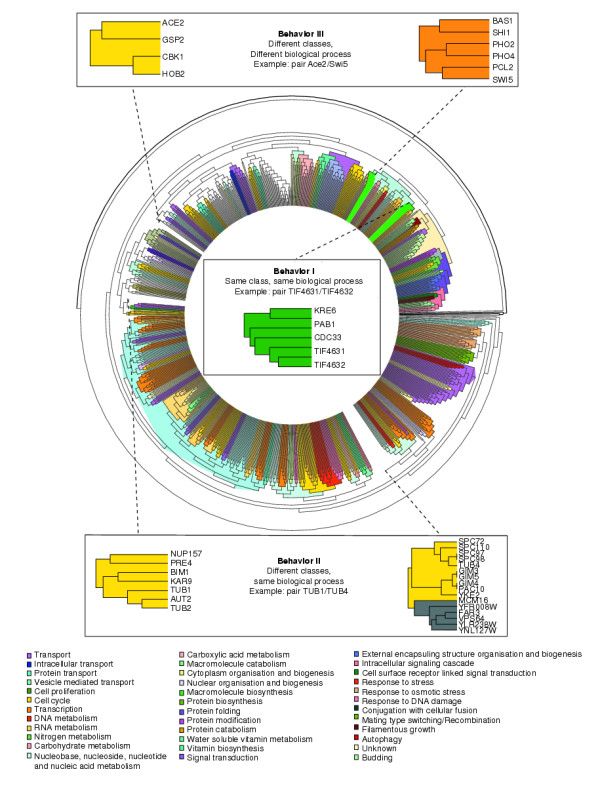
PRODISTIN classification tree for 890 yeast proteins. PRODISTIN classes have been colored according to their corresponding Biological Process annotations. Protein names have been omitted for clarity. The tree contains 41 out of 460 duplicated pairs, the remnant of the ancient whole-genome duplication. Examples of PRODISTIN classes illustrating the three different behaviors of duplicated pairs have been extracted and enlarged from the tree. Their original position in the tree is shown by dashed lines.